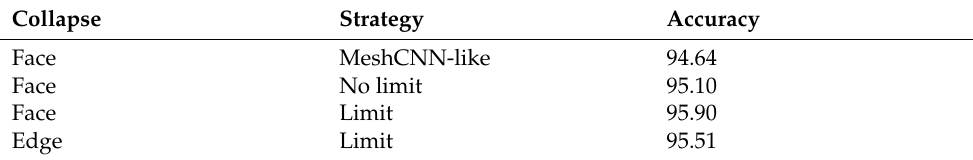
Table 7. Ablation experiments for pooling evaluated on COSEG vases